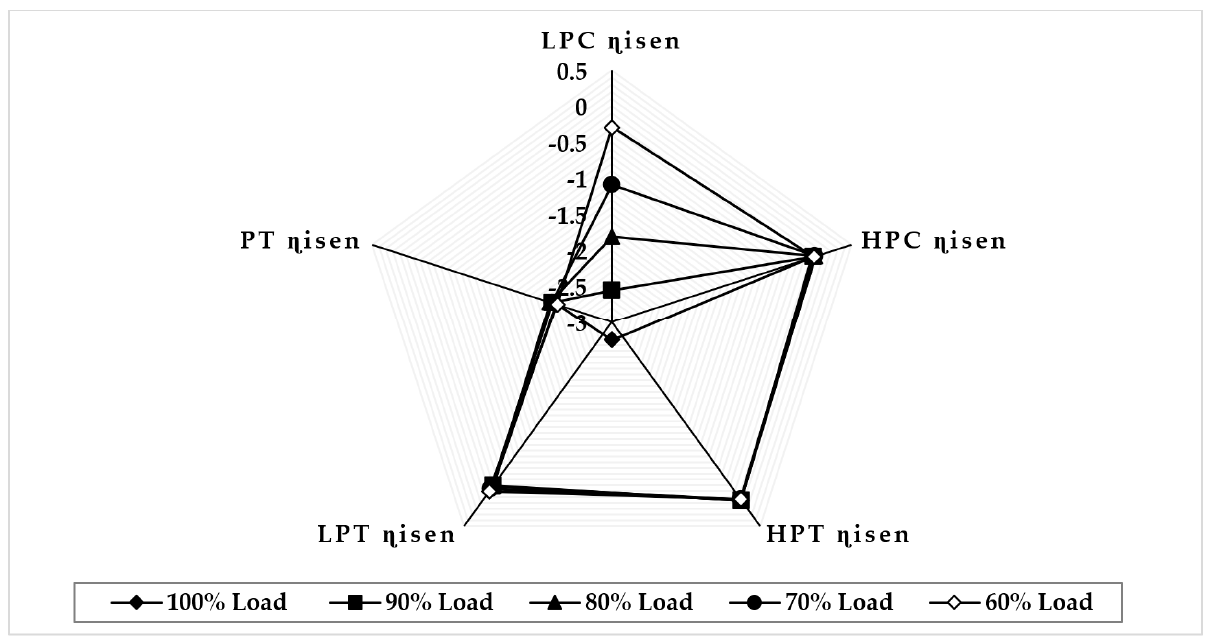
Figure 16. Deviation in component isentropic efficiency due to PT erosion at 100% fault severity at full − load and part − load operation.